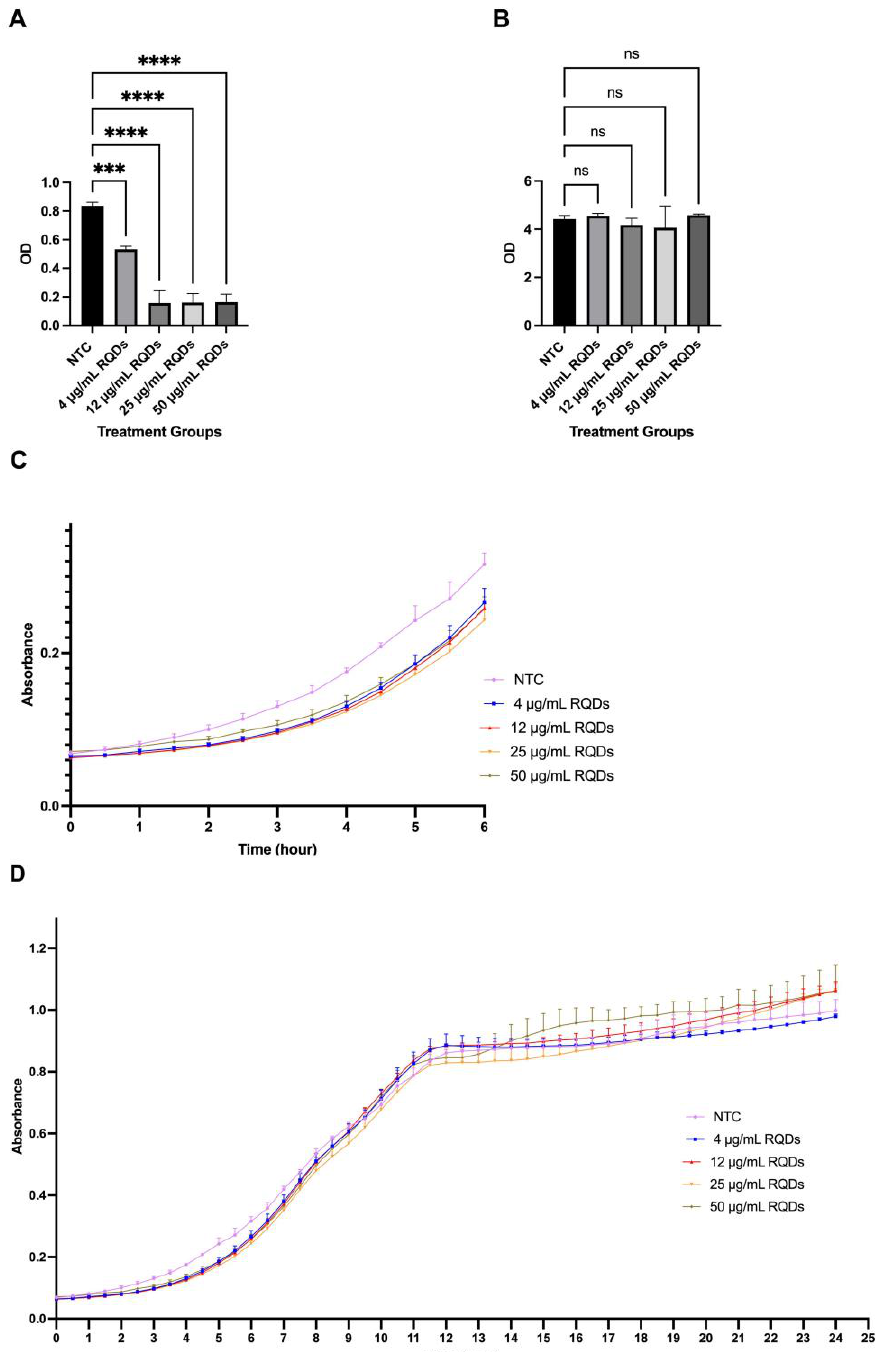
Figure 5. Growth assay to determine the growth rate of yeast in the presence of QDs in SD-HIS. ( A ) Growth assay for yeast cells at 6 h after QD treatment. ( B ) Growth assay for yeast cells at 24 h after QD treatment. ( C ) A 6 h kinetic growth curve of yeast in the presence of quantum dots in various concentrations (0 µ L/mL, 4 µ g/mL, 12 µ g/mL, 25 µ g/mL, and 50 µ g/mL). ( D ) A 24 h kinetic growth curve of yeast in the presence of quantum dots in various concentrations (0 µ L/mL, 4 µ g/mL, 12 µ g/mL, 25 µ g/mL, and 50 µ g/mL). *** p < 0.001, **** p <